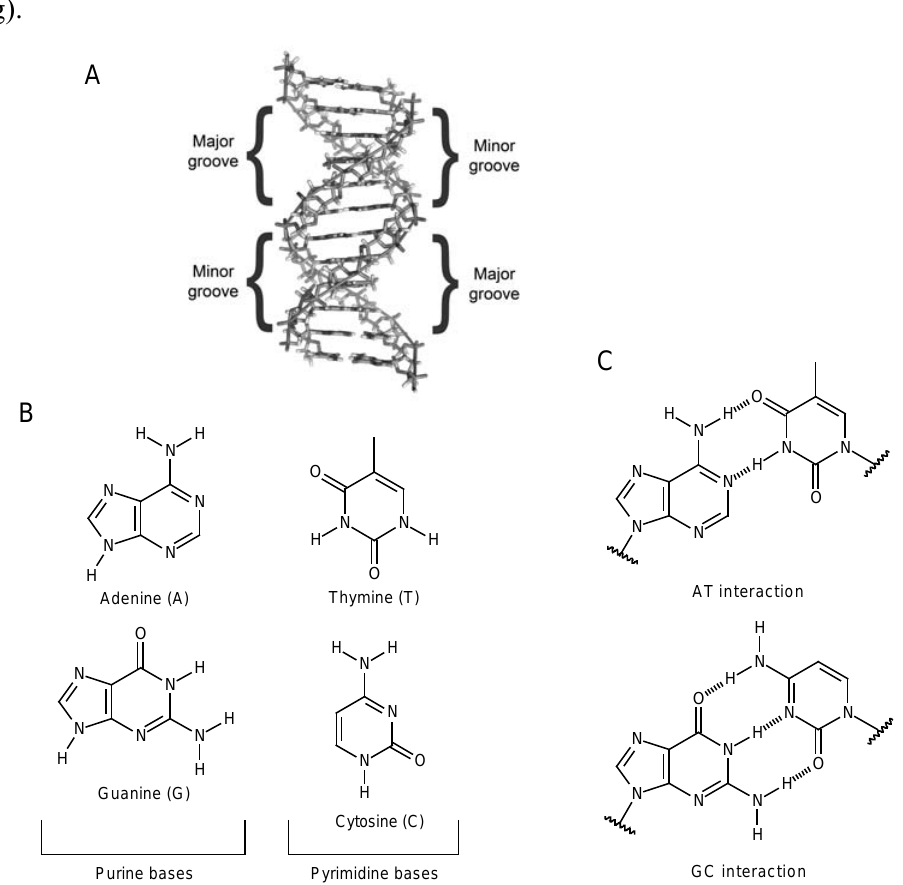
Figure 1. DNA basic 3D structure and bases interactions: (A) DNA and its representative form. Note major and minor grooves indication in the DNA structure; (B) Purine (A and G) and pyrimidine (T and C) bases; (C) Complementary base-pairs interactions (hydrogen